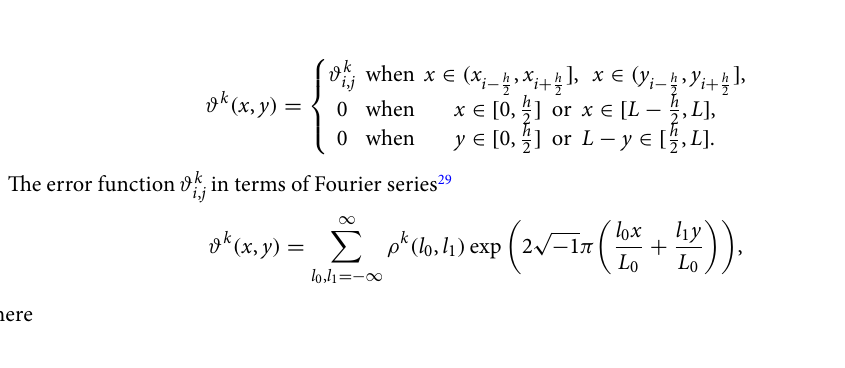
Figure 2. Computational molecule for the proposed scheme